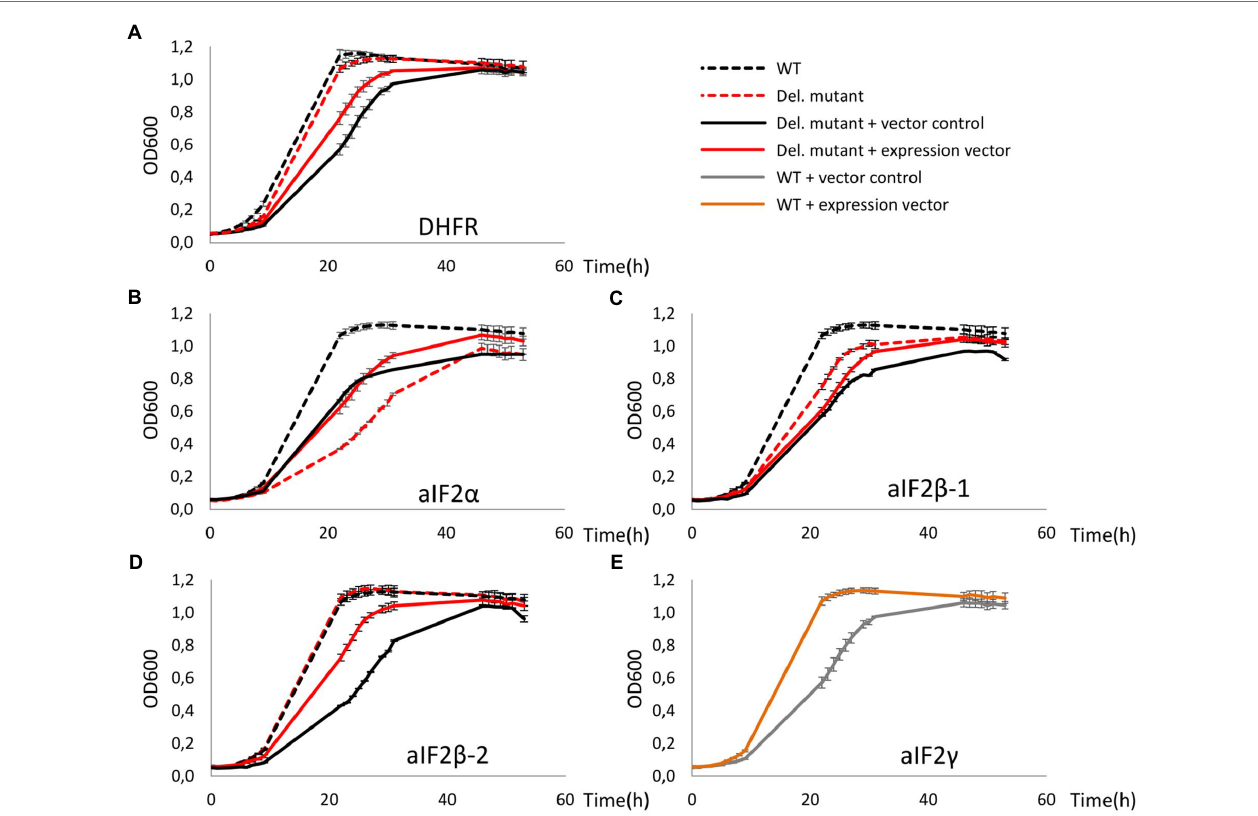
FIGURE 2 | Growth curves of deletion mutants of dhfr and genes for aIF2 subunits as well as of the respective overproduction strains. All cultures were grown in triplicates under optimal growth conditions in complex medium in 96-well plates. The OD600 was measured frequently, and average values and standard deviations are shown. (A-D) Growth curves of the wildtype are shown in black, growth curves of the deletion mutants are shown in red. Dotted lines – vector-free cultures (medium without antibiotic), solid lines – vector-containing cultures (medium with 0.5 μ g/ml Novobiocin). The missing proteins in the respective deletion mutants are indicated at the bottom. (E) The essential aIF2 γ -subunit was overproduced in the wild type. Gray – wildtype with the empty vector, orange – wildtype with the expression